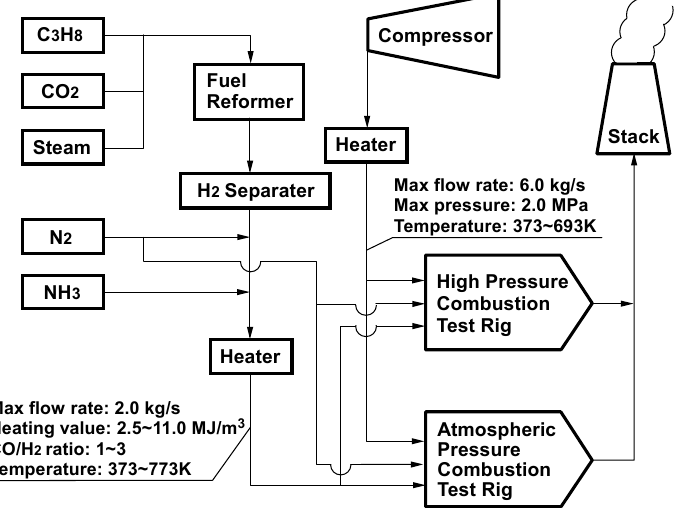
Figure 45. Schematic diagram and specifications of test